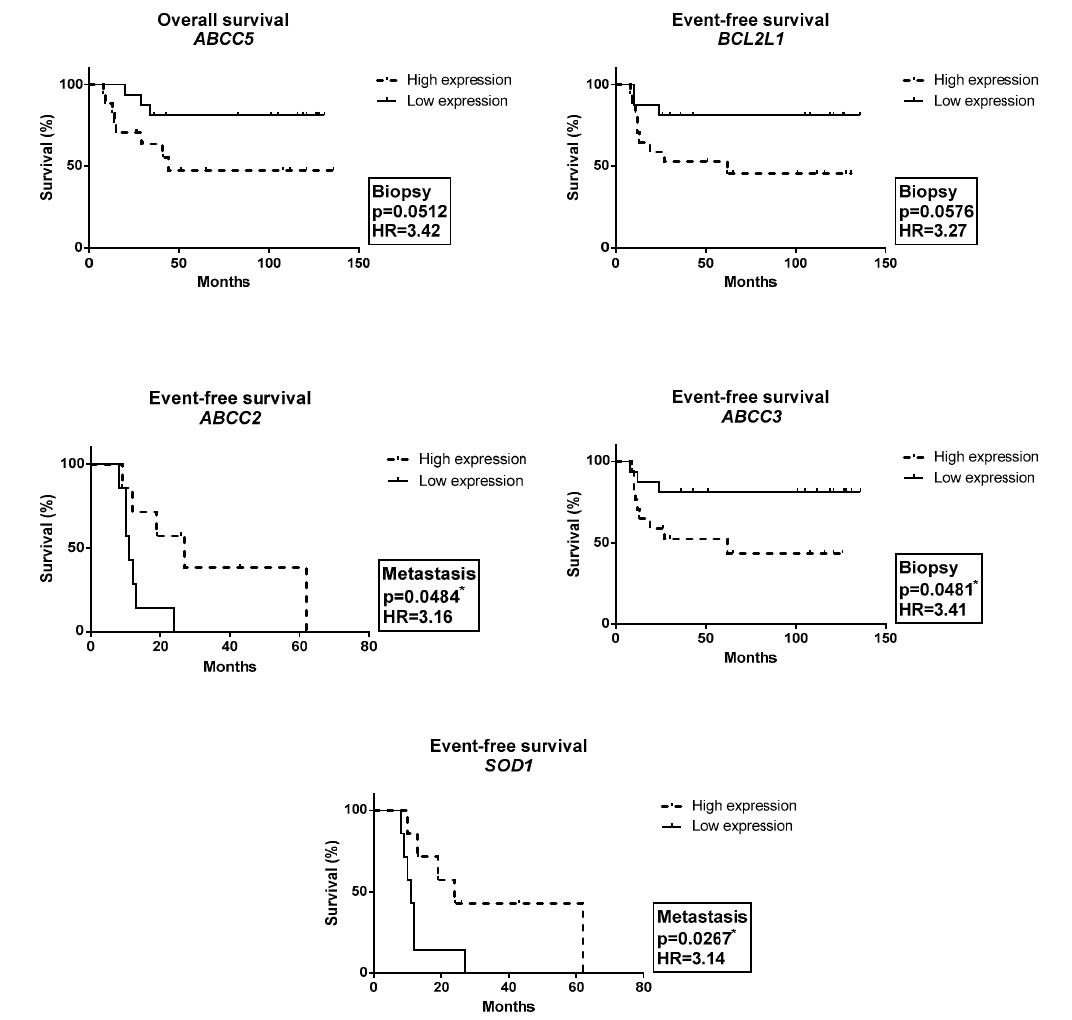
Figure 2. Association between gene expression and survival in OS. Pre-chemotherapy (Biopsy); Post-chemotherapy (Surgery); and Metastasis (M). * p < 0.05; ** p < 0.01.